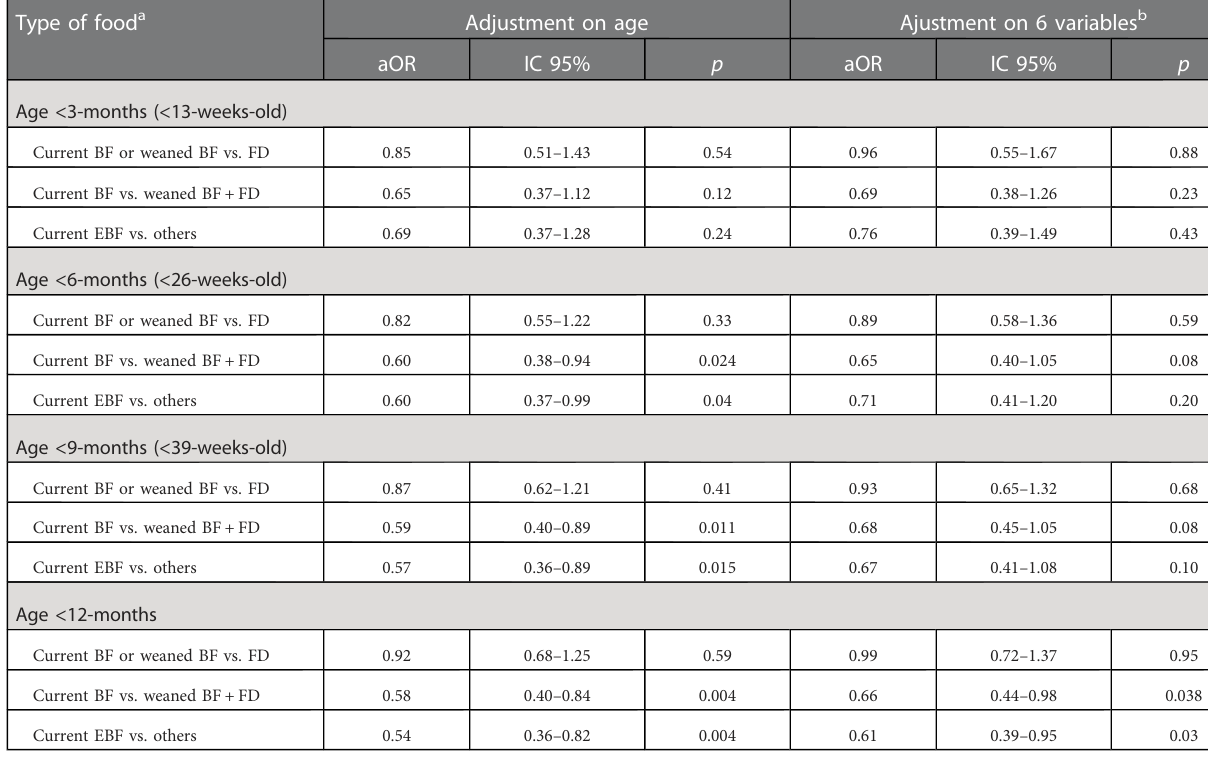
TABLE 4 Comparison of food since birthday between infected children and non-infected children by age-group - Multivariate analysis (multiple logistic regression). Type of food